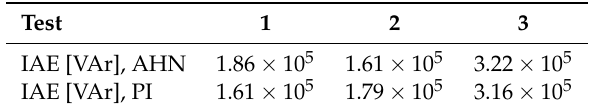
Table 2. Comparison of Robust Scheme and PI: Error. IAE, integral absolute error.